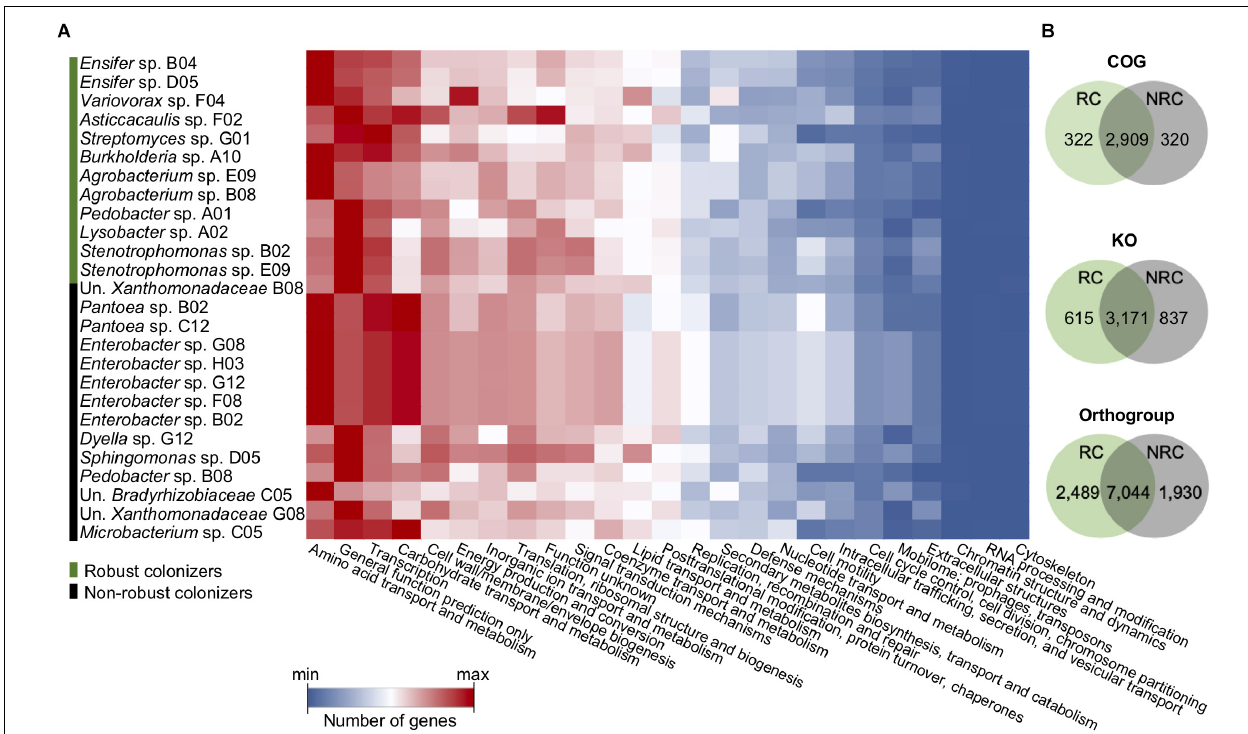
FIGURE 4 | Functional distribution of genes reveals that robust and non-robust colonizer genomes show substantial overlap. (A) Heatmap shows gene count per COG functional categories for individual genomes for robust and non-robust colonizers. (B) Shared number of COGs, KOs, and orthogroups between robust colonizers (RC) and non-robust colonizers (NRC). Un.,